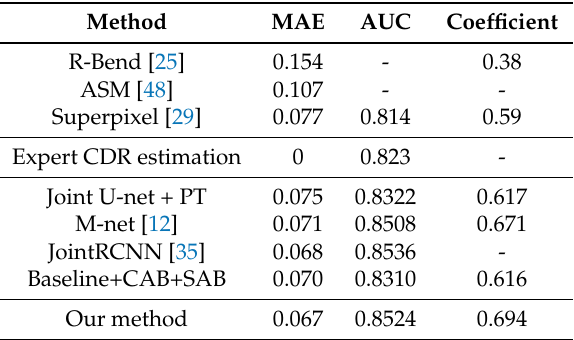
Table 2. The results of different methods.